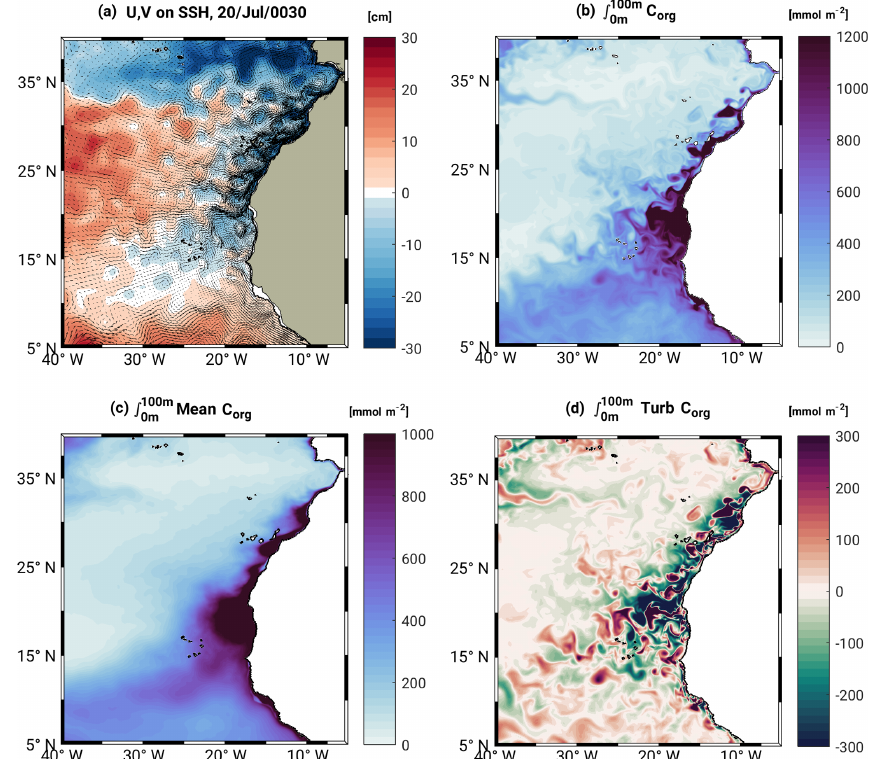
Figure 4. Modeled 2 day mean variables for 19–20 July of year 33 of the simulation. (a) SSH [cm] (color shading) and currents u (vectors); (b) Total organic carbon stock ( R 100m C org ) and turbulent part ( R 100m C org ) as well as its (c) mean ( R 100m C (cid:48) org ), respectively. The C org is 0 0 0 integrated throughout the first 100m of